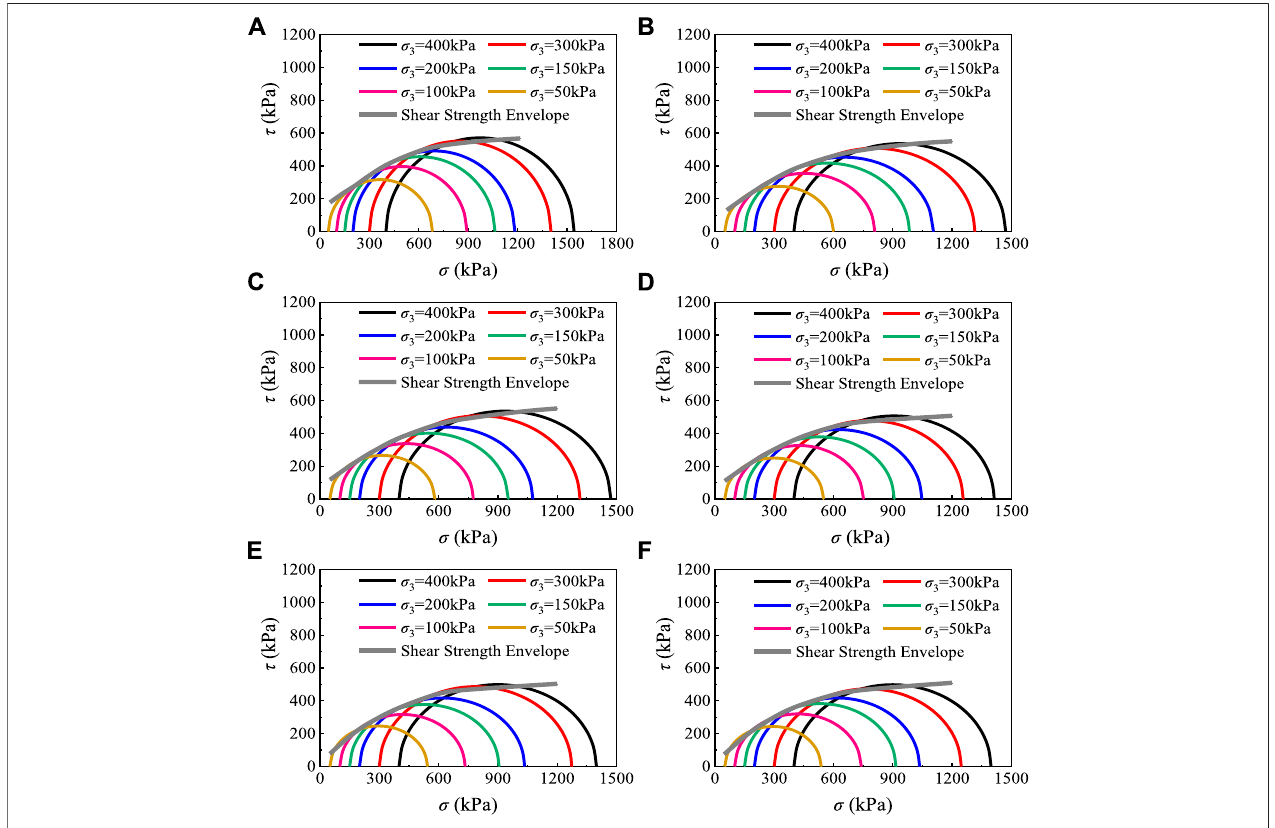
FIGURE 7 | Mohr semicircles and calculated envelopes in this study. (A) 0 FT cycle. (B) 1 FT cycle. (C) 3 FT cycles. (D) 6 FT cycles. (E) 10 FT cycles. (F) 15 FT cycles.